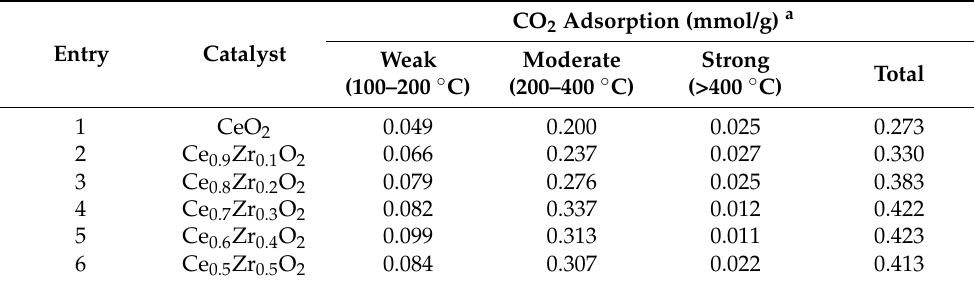
Table 3. Basic amounts of the catalysts calculated from CO 2 -TPD